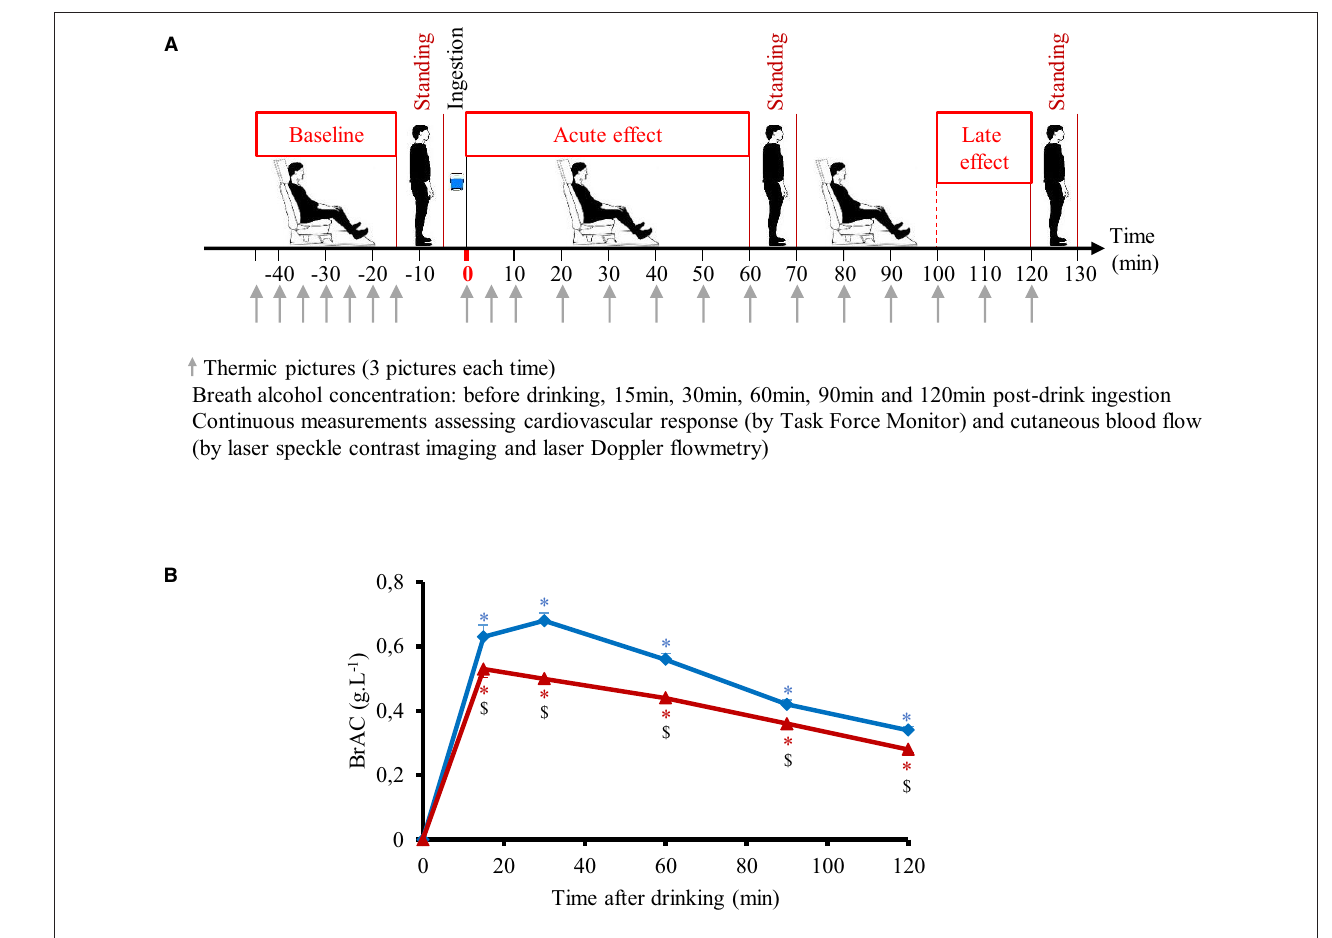
FIGURE 1 | (A) Study design including the different periods of sitting and active standing. (B) Time course of the changes in breath alcohol concentration (BrAC) after drinking water + vodka ( ) or water + vodka + sugar ( ). BrAC at 15min includes 21 subjects because BrAC at this timepoint was not measured in the first three subjects included in the study. All other timepoints include 24 subjects. * p < 0.05 significant differences over time from baseline values; $ p < 0.05 significant different between responses to the drinks.